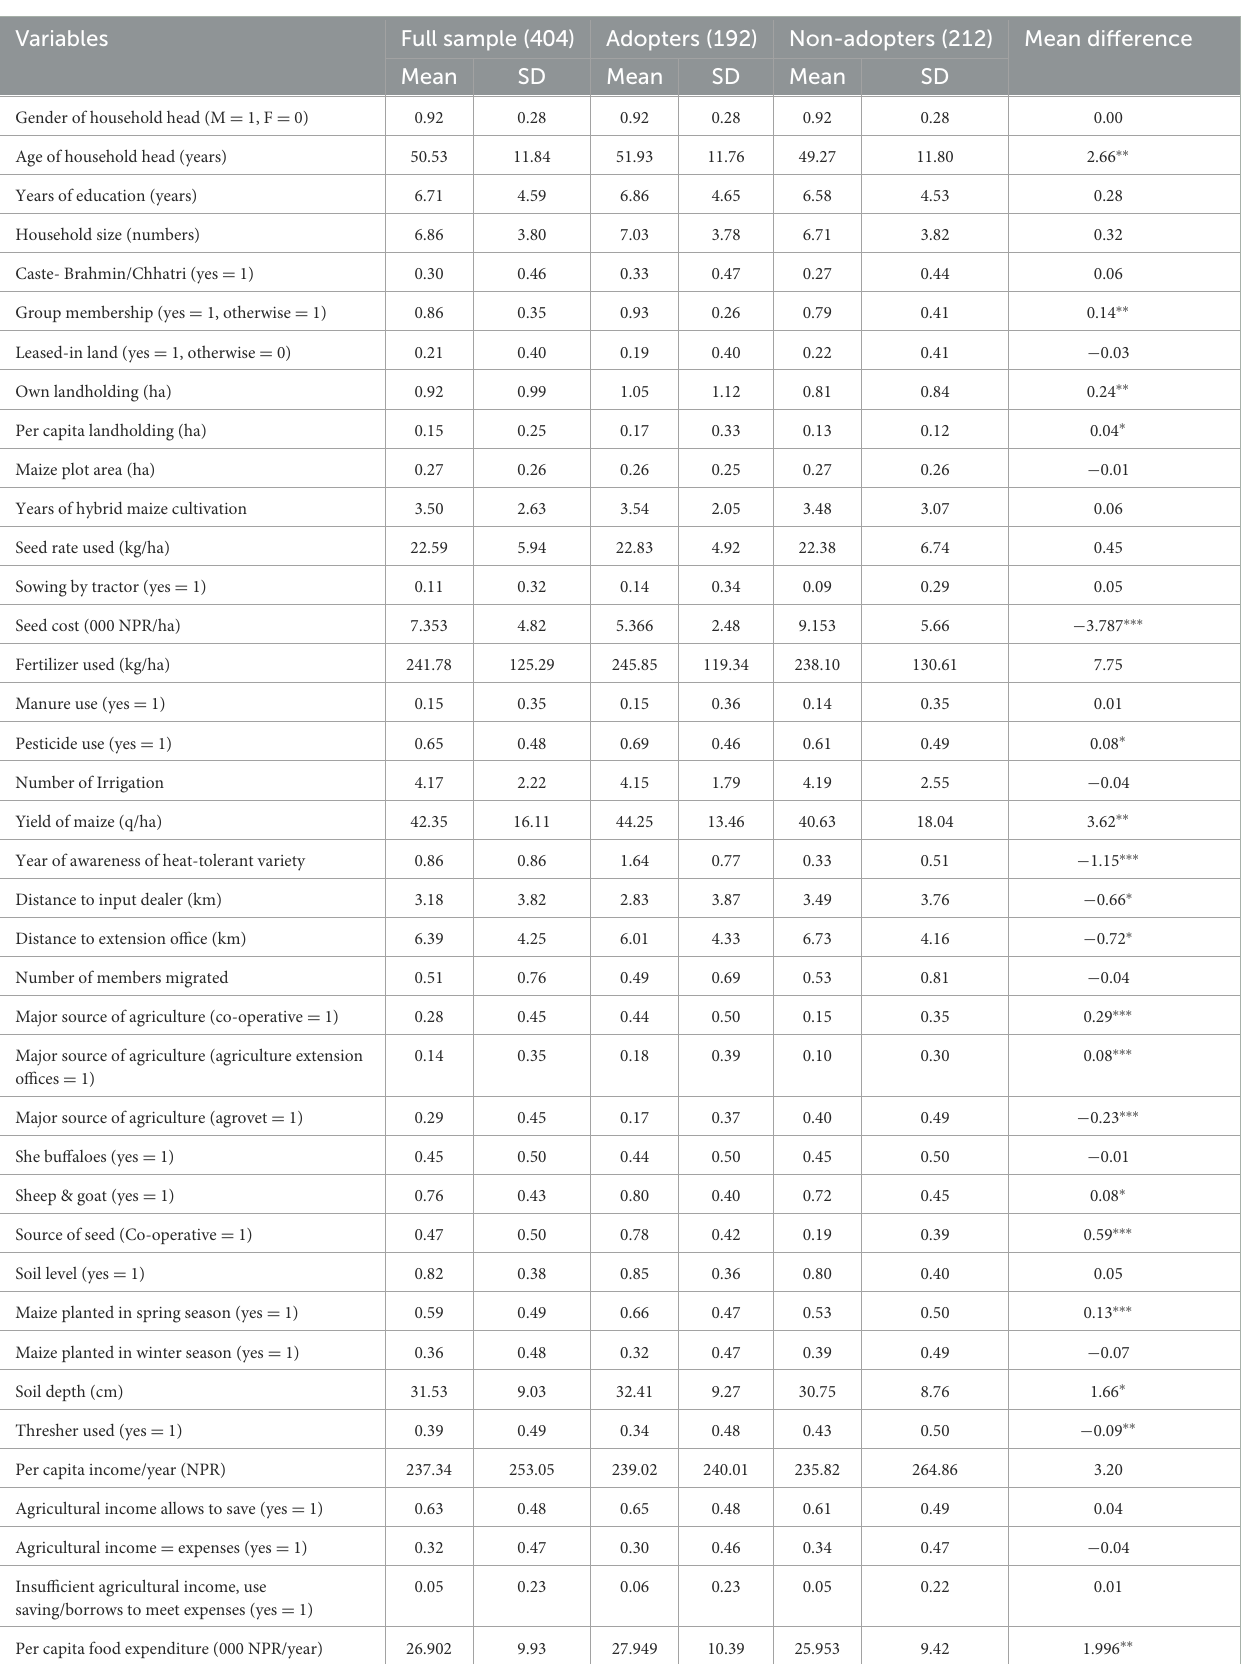
TABLE 1 Selected socio-economic characteristics of sample respondents.